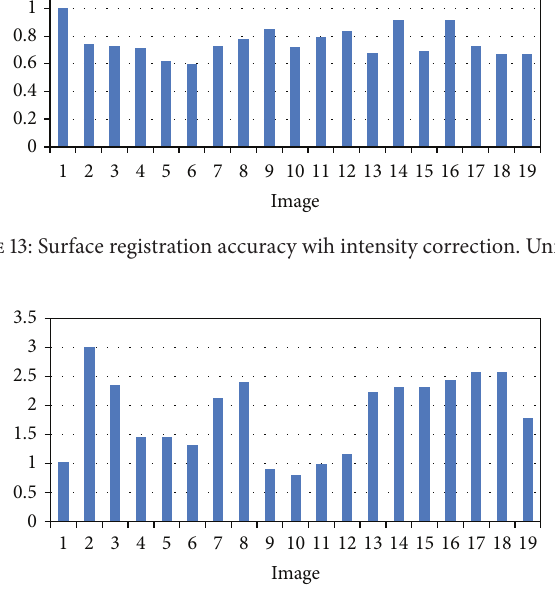
Figure 14: Surface registration accuracy without intensity correction. Unit: mm.